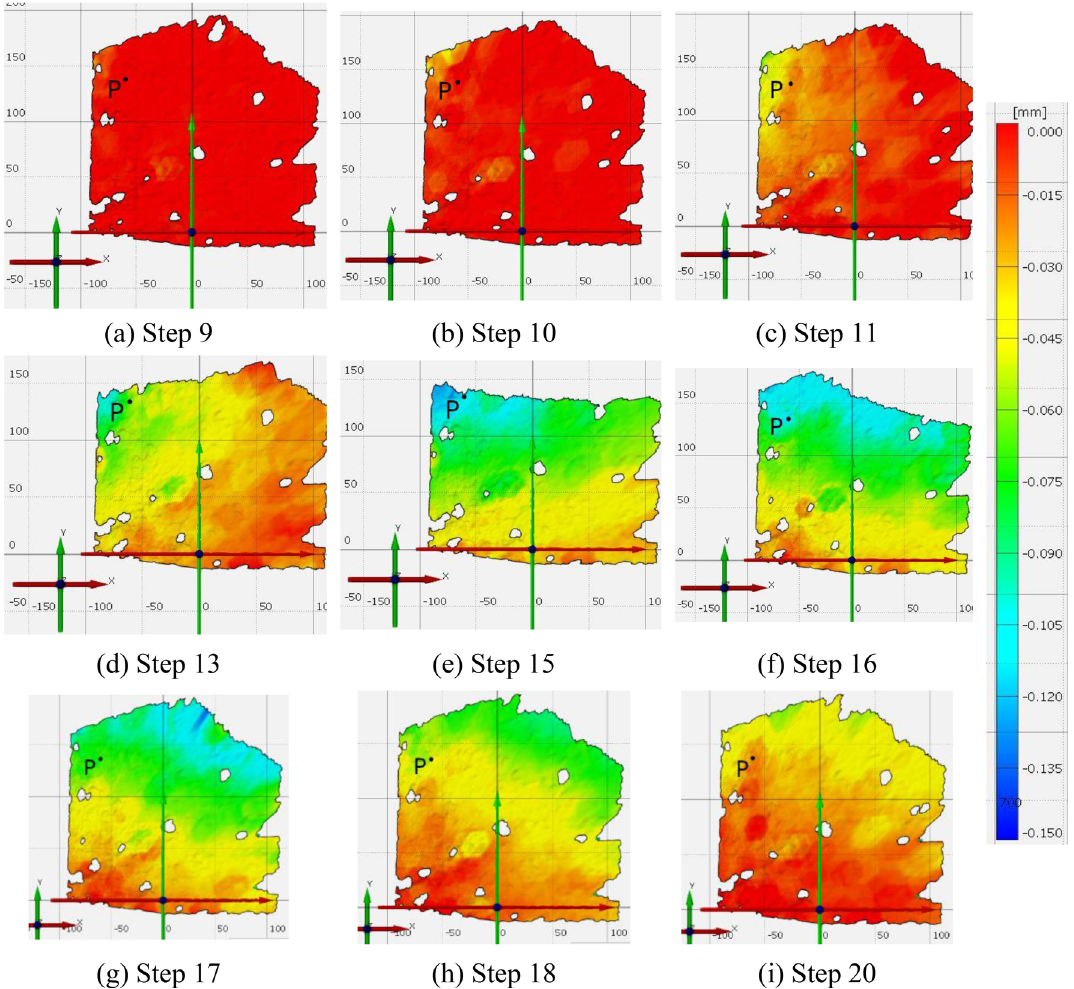
Figure 6. Representative deflection conditions captured by the DIC system. The direction of wheel motion is the X-axis and the border of the pavement contact area coincides approximately with Y = 160 mm. The point P is the closes point in which measures were recorded in all